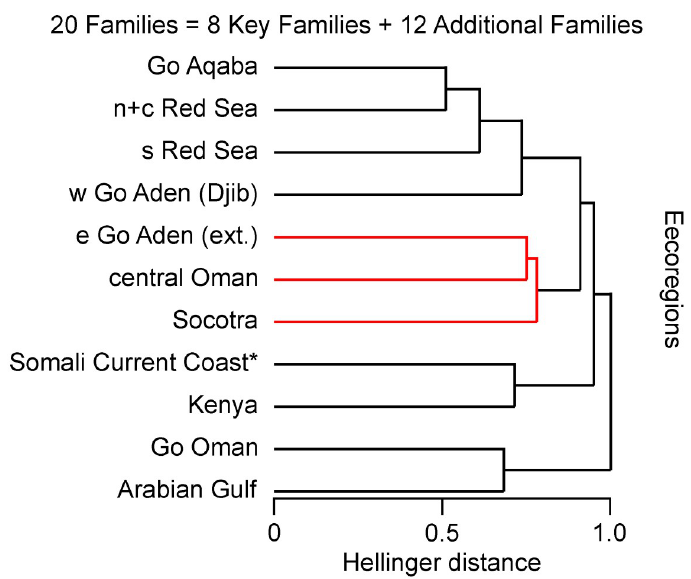
Fig 6. Resemblance pattern of 10 putative Arabian ecoregions and Kenya (20 core families, 898 species) based on Hellinger distance, represented as plot of the dendrogram of the hierarchical agglomerative cluster analysis, verifying the analysis of 8 key families shown in Fig 4 (within-cluster data structure without SIMPROF support indicated in red).